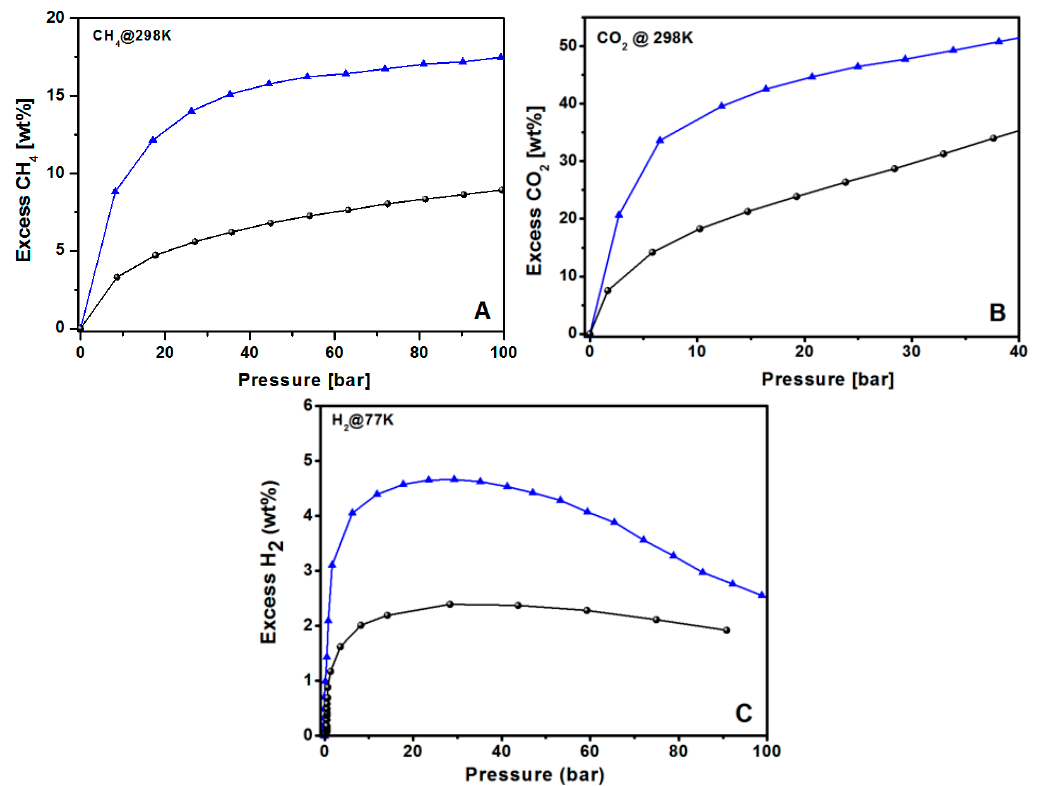
Figure 8. Gravimetric excess adsorption isotherms of UPO16 (black circles) and KUPO16-2-750 (blue triangles) for ( A ) methane (298 K, up to 100 bar), ( B ) carbon dioxide (298 K, up to 40 bar), and ( C ) hydrogen (77 K, up to 100 bar).